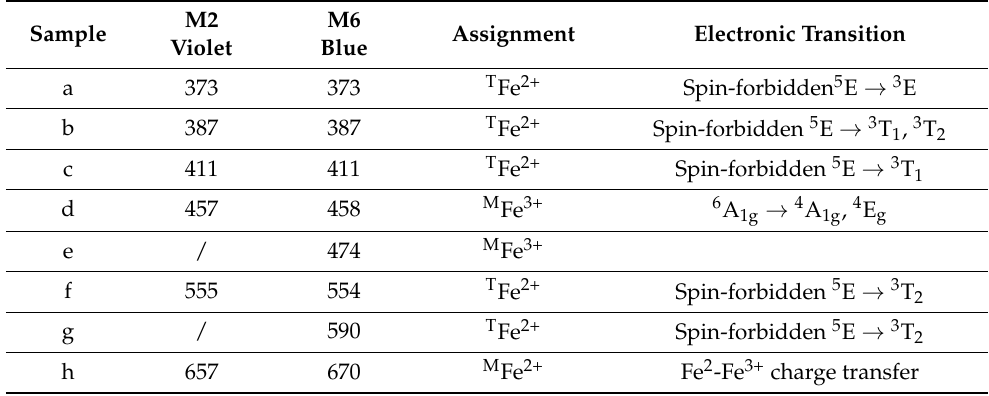
Table 4. UV-Vis spectral peak positions of the blue series samples M2, M6 [29–32].